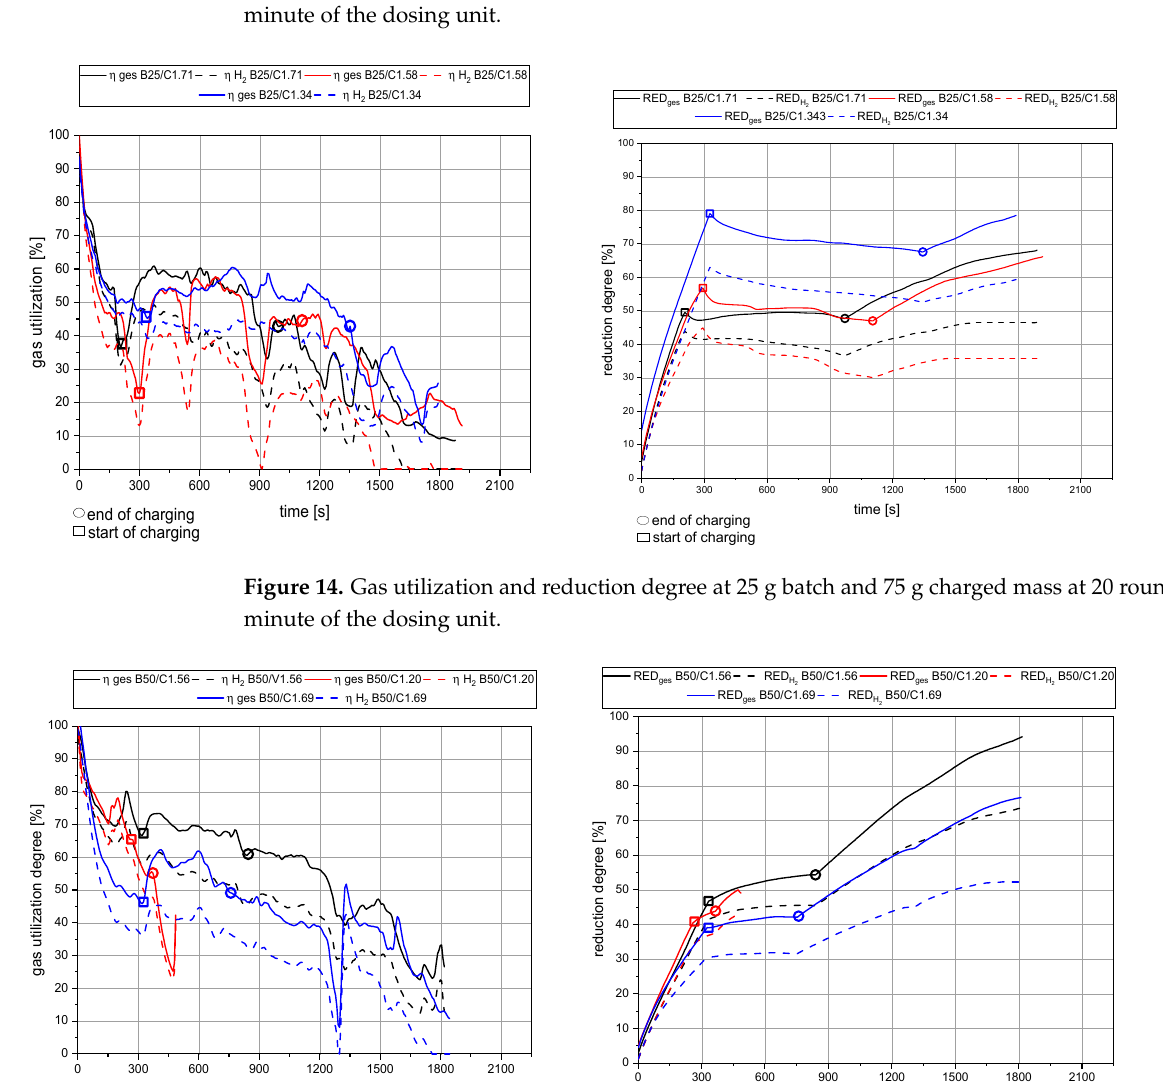
Figure 16. Gas utilization and reduction degree at 100 g batch and no charged mass. Phase two is of significant interest for this investigation because the slope indicates the reduction kinetics. An ascending slope means that the introduced mass flow of oxygen via the ore is lower than the reduction process’s decreased amount. A descending slope means the exact opposite, and a steady RD line indicates an equilibrium between these two mass flows. 4.2. Detailed Discussion of the Results for All Three Phases Figure 17 summarizes four representative curves for the reduction degree while op- erating at different setups. Out of the direct comparison of the curves in Phase 1, the pre- reduction step, the following significant points were observed: •